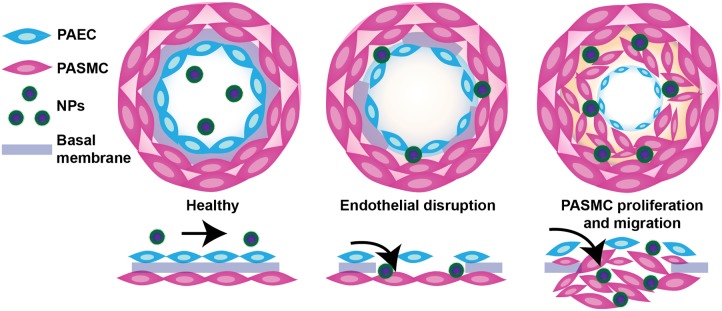
Schematic representation of endothelial dysfunction in PAH and a proposed mechanism of NP extravasation into pulmonary vasculature. While healthy pulmonary vasculature is a semipermeable membrane barrier, the vasculature in lungs undergoing PAH exhibits endothelial dysfunction arising from a chronic inflammatory state and hypoxia, leading to fenestrations (openings) in the endothelium and a hyperpermeable state. Such permeability may be exploited by NPs to passively extravasate and accumulate in lungs undergoing PAH. Figure adapted from Segura-Ibarra et al. (2017), reproduced with permission courtesy of Elsevier.